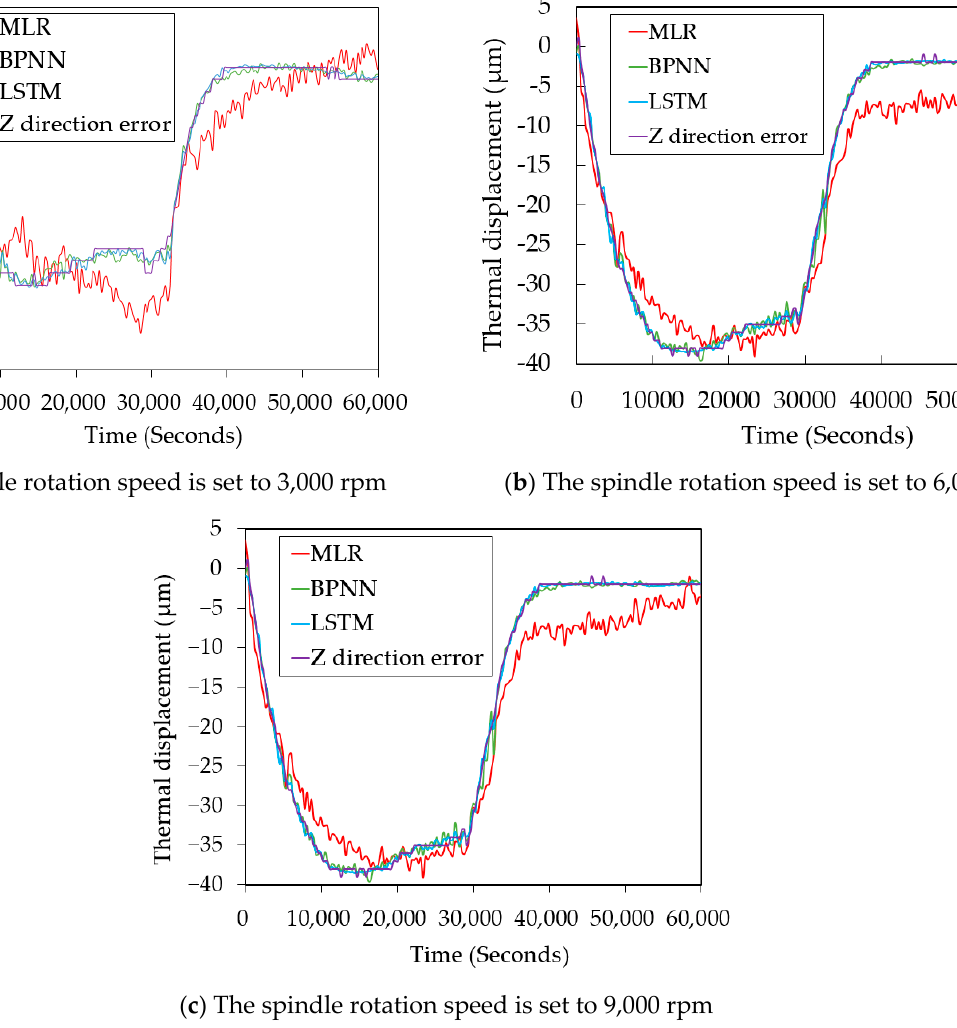
Figure 10. Comparison estimation results of MLR, BPNN, and the proposed LSTM modeling methods at different spindle rotation speeds.